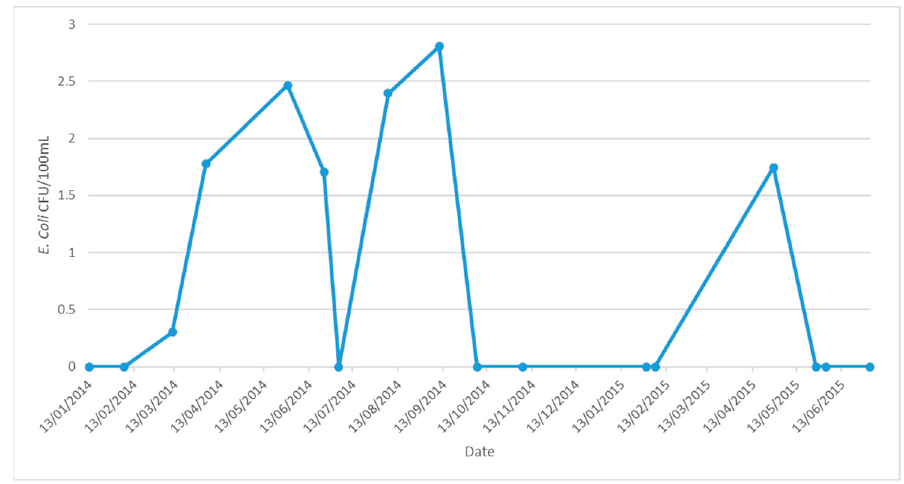
Figure 2. Data of E. coli (CFU/100mL) at the outlet pipe of the WWTP.